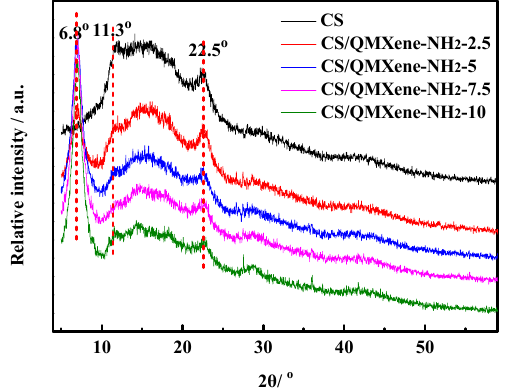
Figure 6. XRD patterns of control CS and CS/QMXene-NH 2 membranes.